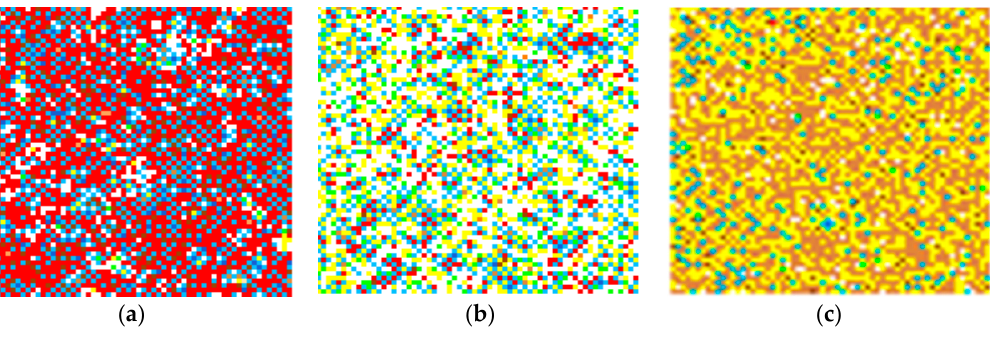
= 0.2; ( b ) y = 0.5; ( c ) y = 0.7; = 0.2; ( b ) 𝑦 (cid:3004)(cid:3009) = 0.5; ( c ) 𝑦 (cid:3004)(cid:3009) = 0.7; T CH 4 CH 4 (cid:3120) (cid:3120) (cid:3120) 4 (cid:4) = H (cid:4) = COOH*). = H = COOH*). 2 O*, 2 *, 2 O*, ■ 2 *, ■